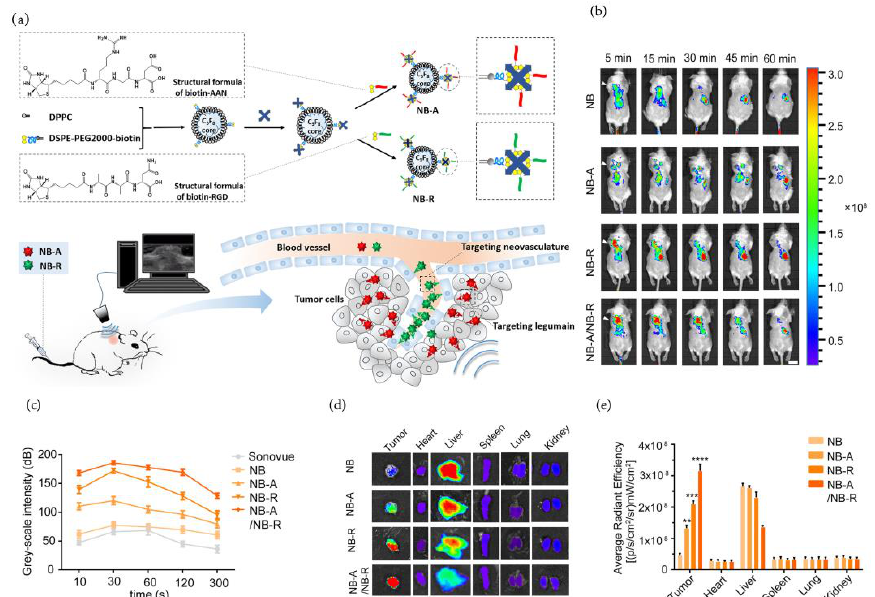
Figure 8. ( a ) Schematic illustration of the fabrication process of AAN-modified NBs (NB-A) and RGD-modified NBs (NB-R) with their application for tumor and neovascular dual-targeted ultrasound imaging of cancer tissue. ( b ) Time course of in vivo fluorescence images of 4T1 mouse breast cancer models injected with DiI-labeled NB, NB-A, NB-R and NB-A/NB-R over time (5, 15, 30, 45, 60 min). ( c ) Corresponding time-intensity curves grayscale ultrasound imaging of tumors after injection of SonoVue MB, NB, NB-A, NB-R and NB-A/NB-R at various time points (10, 30, 60, 120 and 300 s). ( d ) Ex vivo fluorescence imaging of tumors and major organs (heart, liver, spleen, lung and kidney) excised at 30 min postinjection. ( e ) Bar graph showing the integrated intensities of DiI fluorescence in selected organs. A one-way ANOVA test was used for statistical analysis; ** p < 0.01, *** p < 0.001, **** p < 0.0001 compared with the fluorescence intensity of the tumors in the NB group. [83]. Copyright 2022, Elsevier.